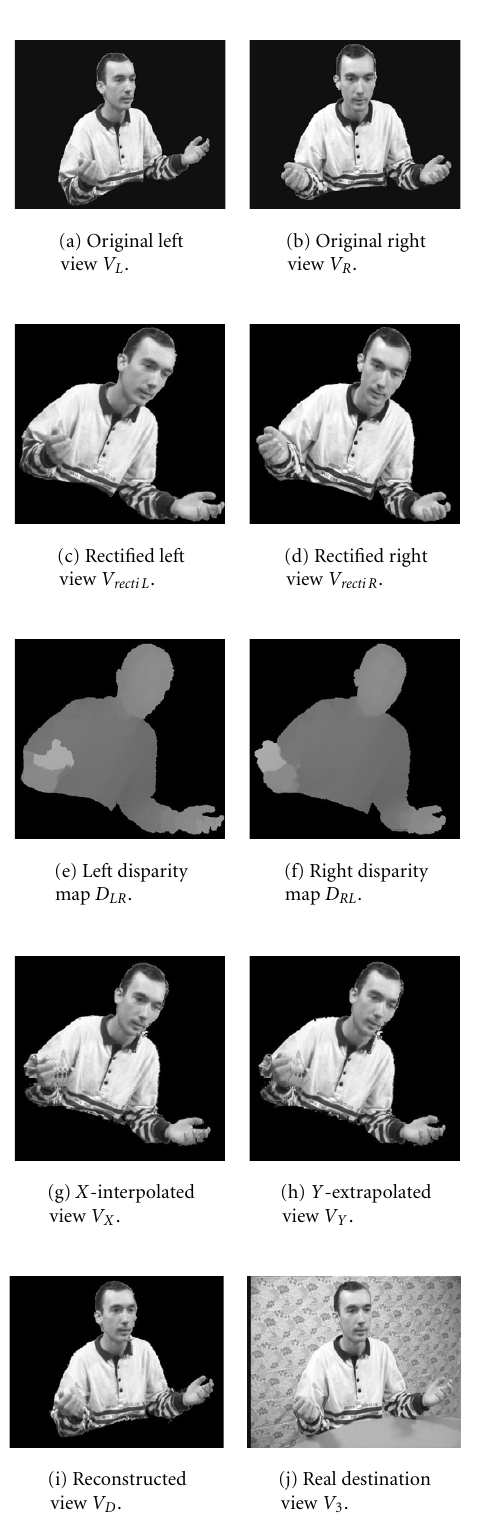
Figure 11: All intermediate and final results from our multi-step view reconstruction algorithm are listed above together with the disparity data. They are based on a pair of stereo frames ((a) and (b)) from the setup shown in Figure 10.